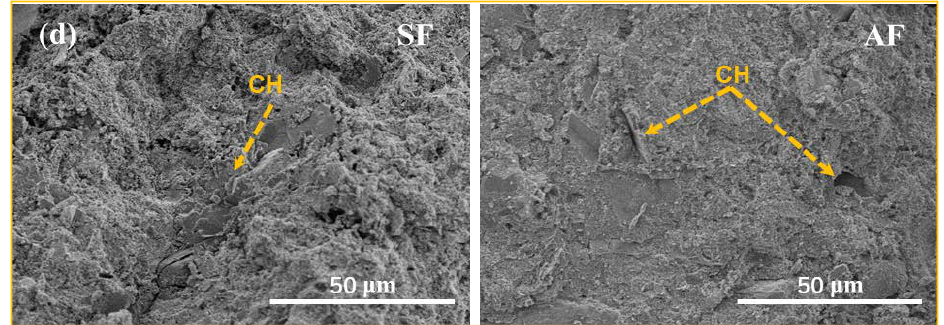
Figure 8. SEM of the skeletal structure of FMLSB: ( a ) 437.5 kg/m 3 , ( b ) 670 kg/m 3 , ( c ) 902.5 kg/m 3 , ( d ) 1170 kg/m 3 .